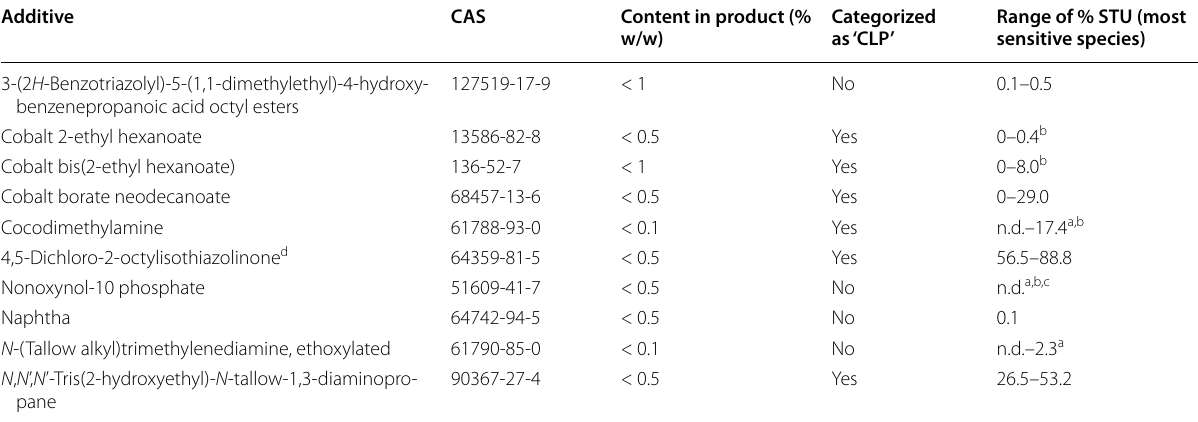
Table 2 Additives in the 21 wood preservative products labelled as hazardous to the environment on the safety data sheet of the respective